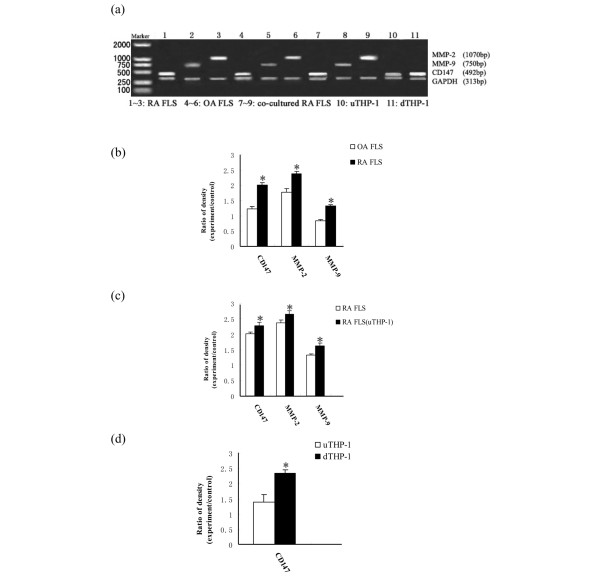
RT-PCR analyses of CD147, MMP-2 and MMP-9 mRNA in fibroblast-like synoviocytes (FLS) from rheumatoid arthritis (RA) patients, from osteoarthritis (OA) patients, and in undifferentiated and differentiated THP-1 cells. Cells were collected and the total RNA isolated by electrophoresis and transferred to a nylon membrane. The membrane was hybridized with CD147-specific, MMP-2-specific and MMP-9-specific cDNAs, and then visualized by autoradiography. (a) and (b) Expression of CD147, MMP-2 and MMP-9 mRNA in RA FLS (lanes 1, 3 and 2) was higher than that in OA FLS (lanes 4, 6 and 5). (a) and (c) Expression of CD147, MMP-2 and MMP-9 mRNA in RA FLS after co-culture with undifferentiated THP-1 cells (lanes 7, 9 and 8) was higher than that in RA FLS (lanes 1, 3 and 2). (a) and (d) Expression of CD147 mRNA of differentiated THP-1 cells (dTHP-1, lane 11) was higher than that of undifferentiated THP-1 cells (uTHP-1, lane 10). Glyceraldehyde phosphate dehydrogenase (GAPDH) was used as the inner parameter. Values (ratio of density = experiment/GAPDH) are the means ± standard error (n = 4–6). *P < 0.05 (experimental groups versus control groups).